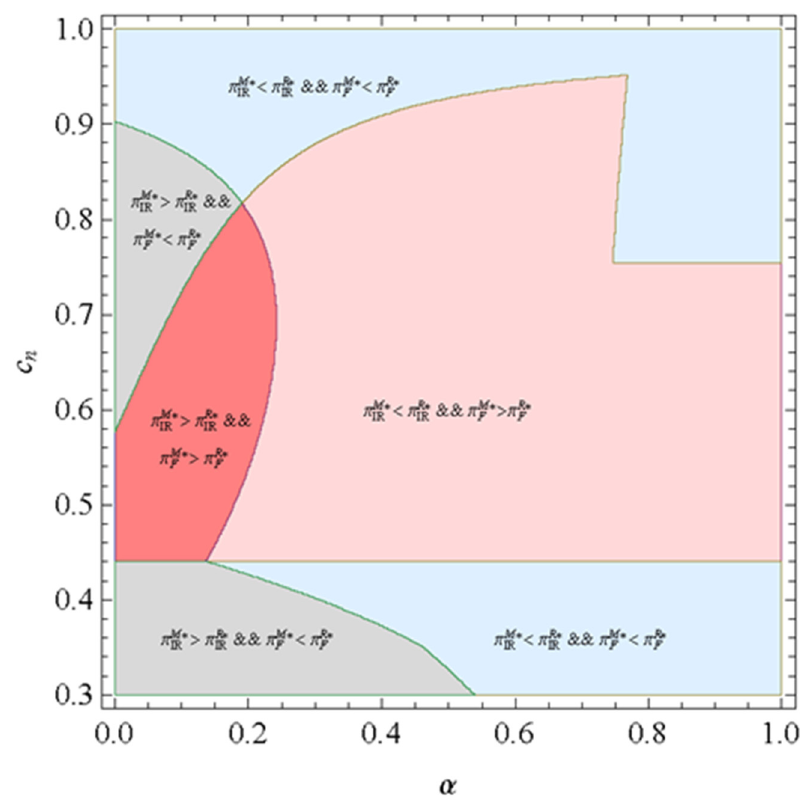
Figure 2. Profits of firm and IR.